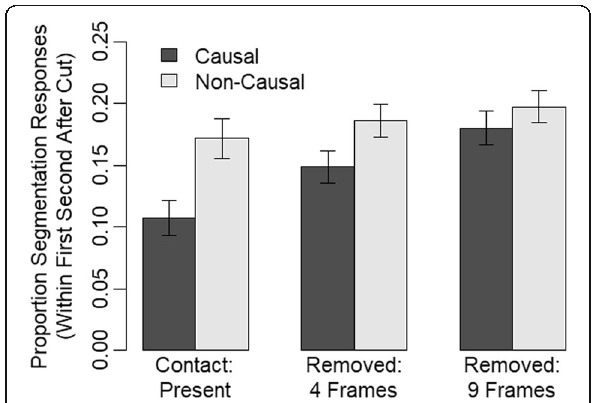
Fig. 6 Results of Experiment 4. Error bars indicate the standard error of the